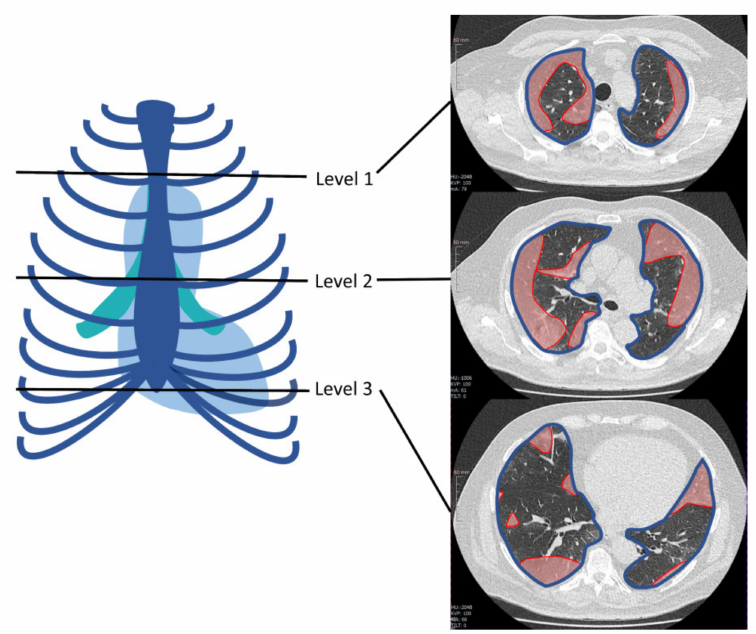
Figure 2. Example of region of interest (ROI)-based simple semi-quantitative (SSQ) determination of lung area involved in chest CT scans of COVID-19 patients at three predefined levels: aortic arch, tracheal bifurcation, and inferior end of xiphoid. In the axial image from each level, red indicates the area of involved lung parenchyma while the blue line outlines the total lung area at that level. Reprinted from Büttner et al. [16] with kind permission of